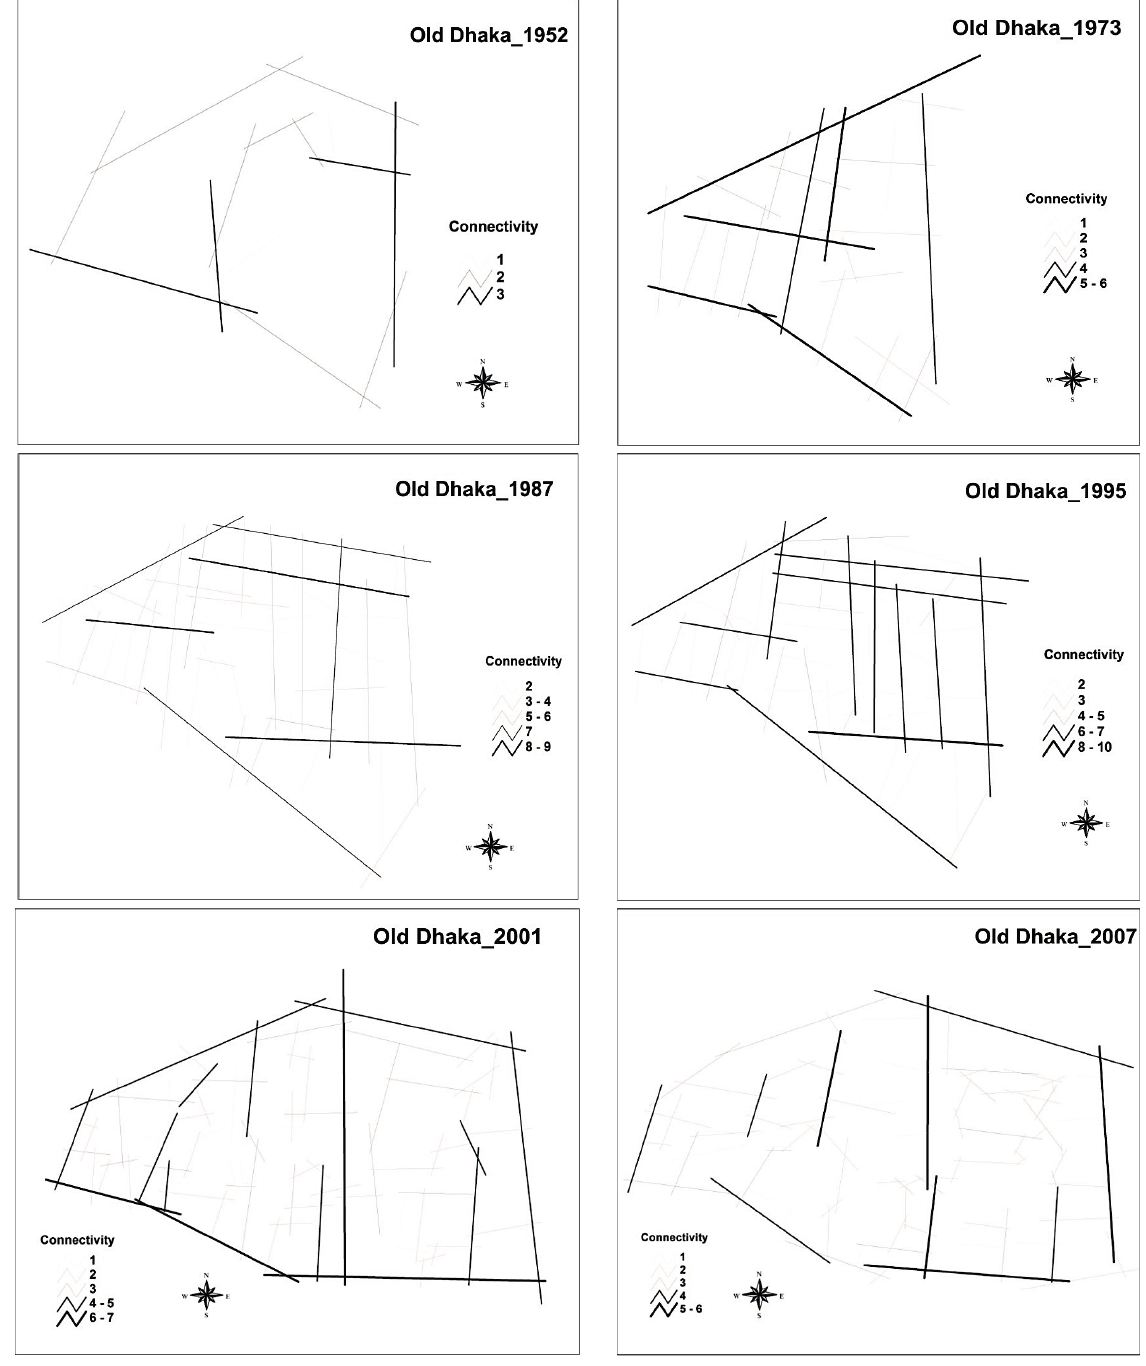
Figure 9. Connectivity maps of ward 72 (Old Dhaka) in different time periods (not to